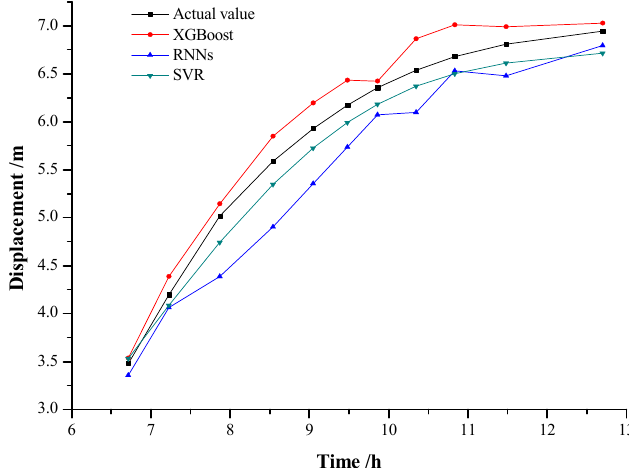
that as the curvature of the curve changes from large to small, the deviation of predicted Figure 6. Variation of displacement predicted values of D5 with time. Figure 6. Variation of displacement predicted values of D5 with time. values obtained using RNNs from real values becomes larger and larger.